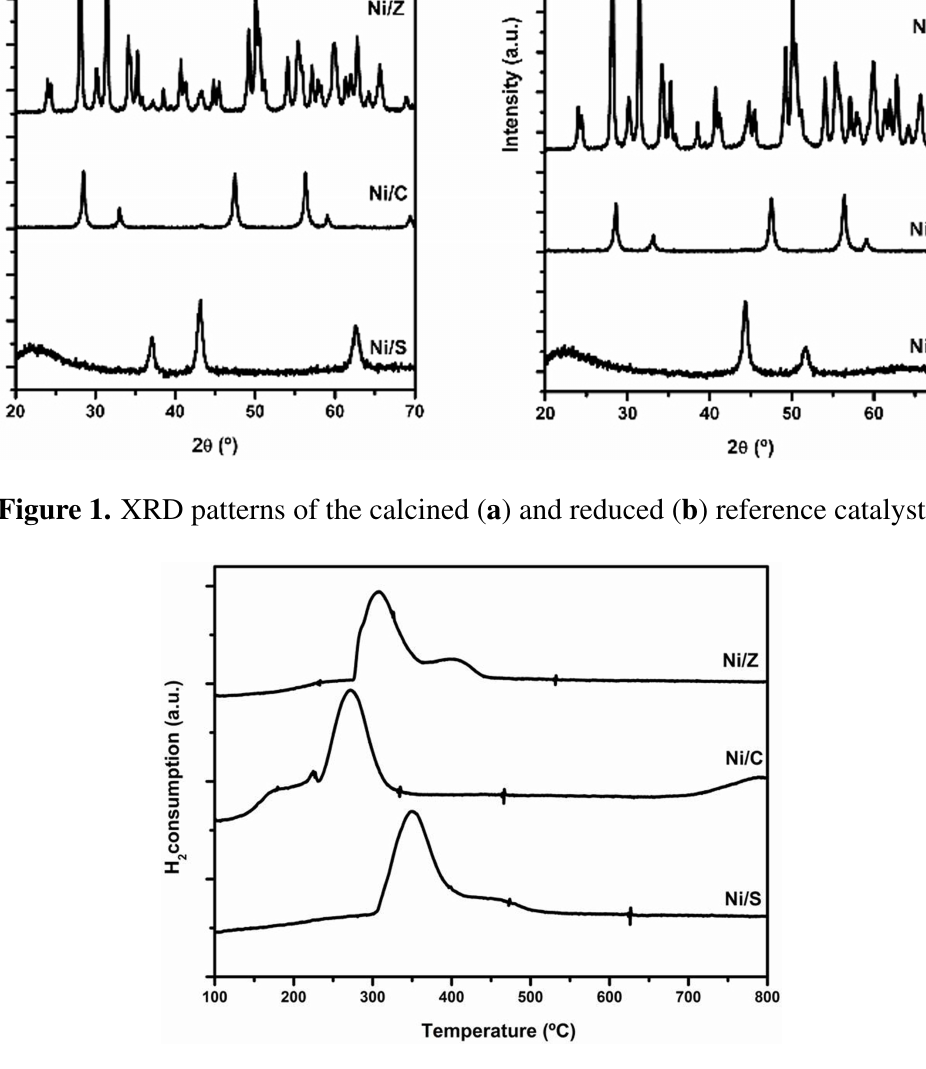
Figure 2. Temperature programmed reduction (TPR) profiles of the calcined reference